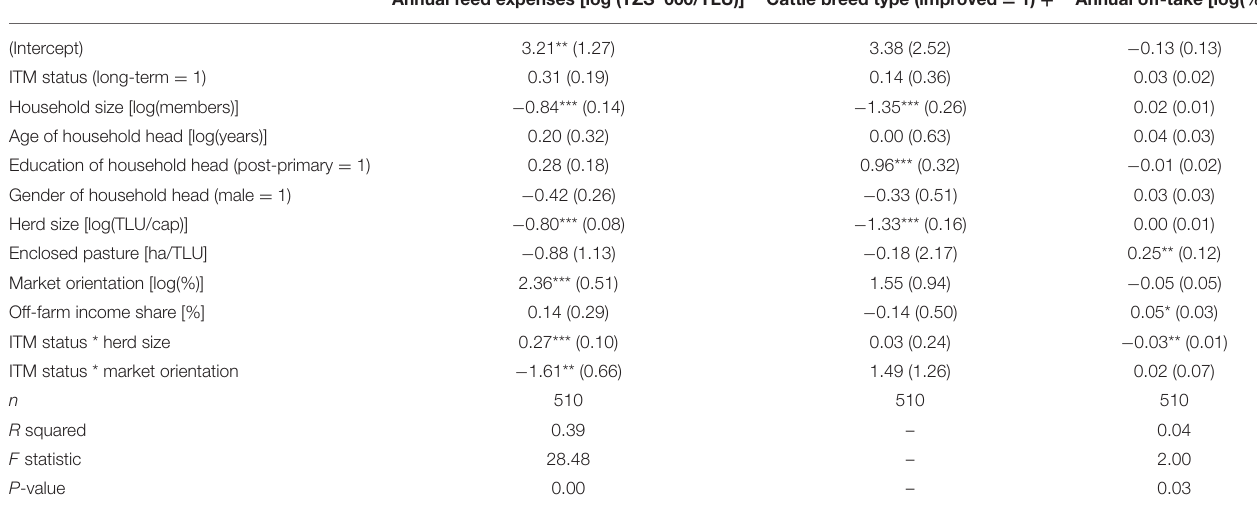
TABLE 5 | ITM vaccination and indicators of farm management